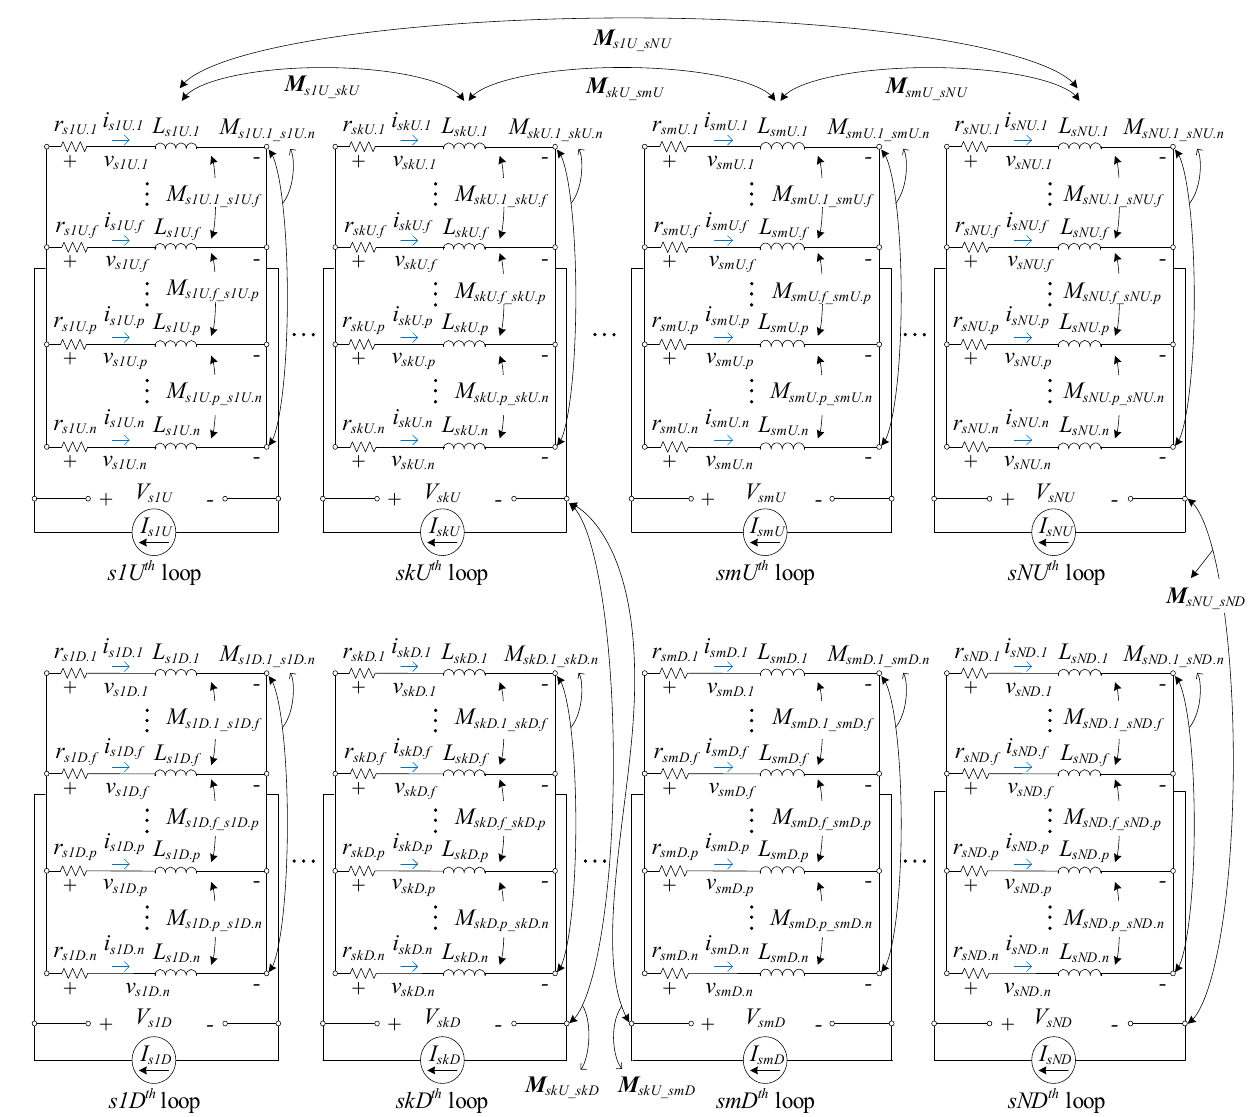
Figure 4. The equivalent circuit of the double-layer planar spiral coil of n turns shown in Figure 3 for analysis using the VFM.